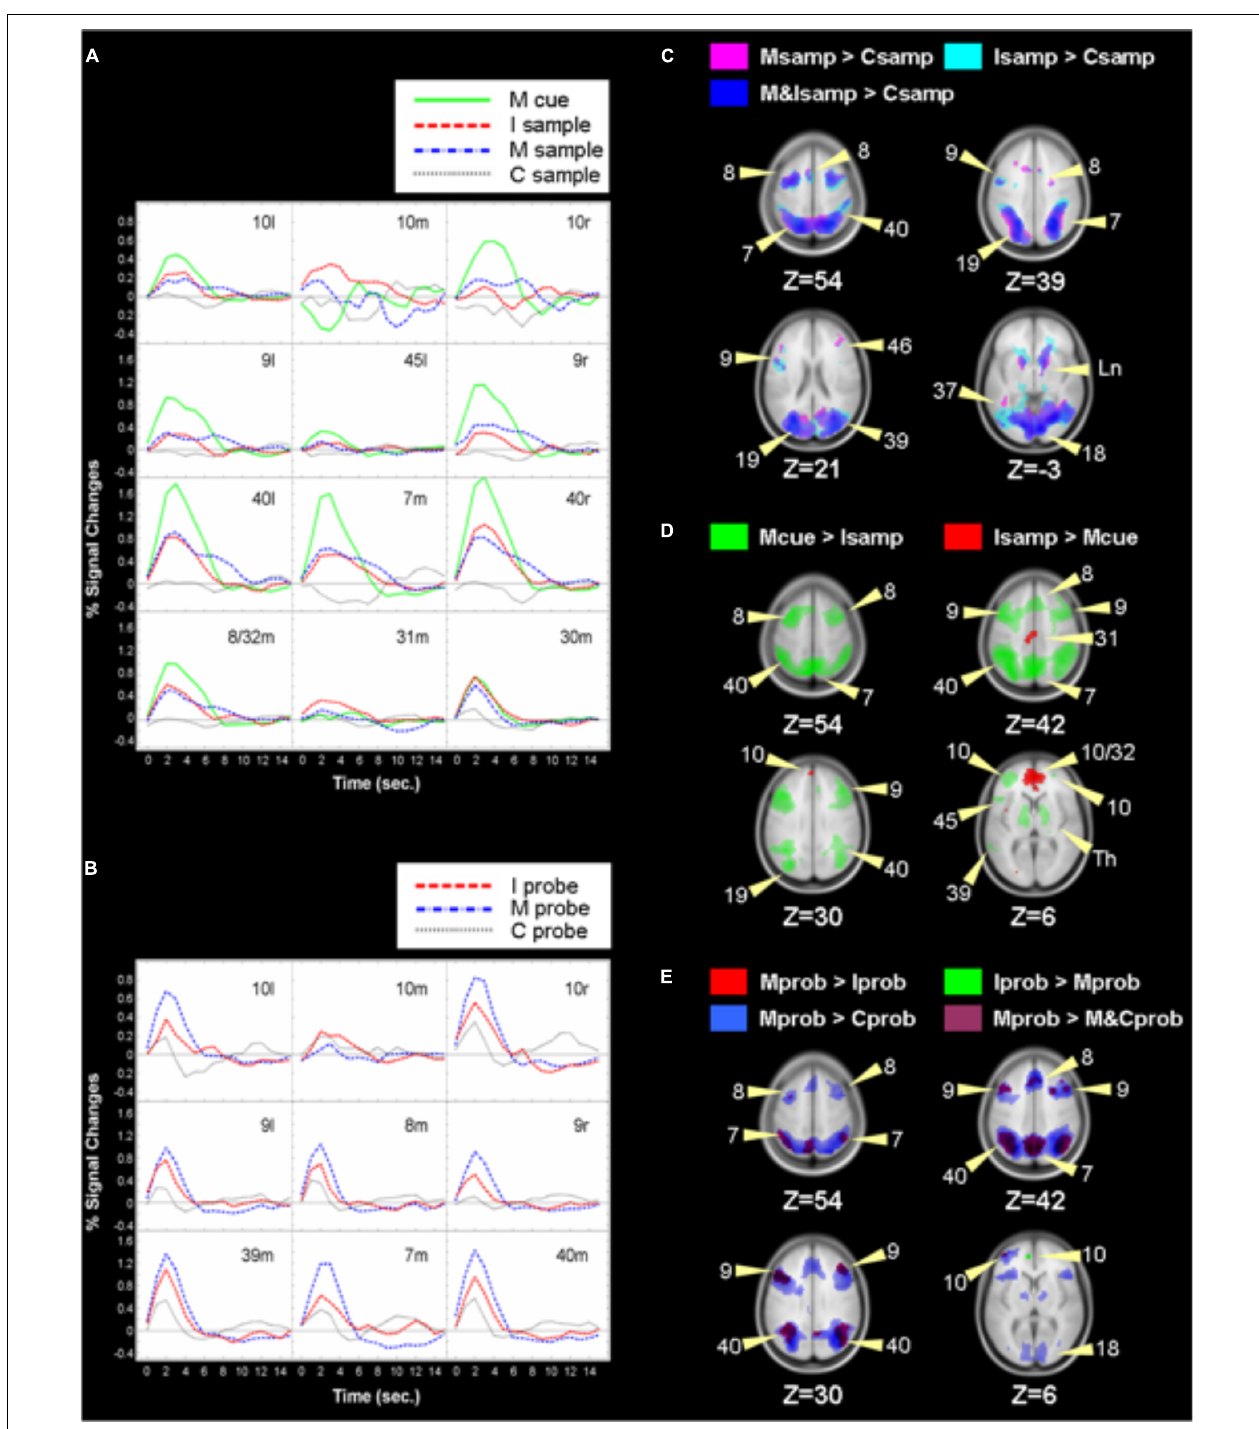
FIGURE 3 | Labels refer to Brodmann’s areas and left or right hemisphere or medial. For example, in panel (A) , 10l refers to left Brodmann Area 10 in the left hemisphere. The green line represents activation or BOLD intensity in that area during the manipulate trials’ cue phase. We compared responses for trial phases and depicted them in panels (C–E) , with labeled arrows indicating Brodmann Areas. The subtraction of the integrate trial sample phase from the manipulate trial change cue phase resulted in significant activations shown in green in panel (D) . The opposite subtraction produced the medial red activations. The green ROIs’ activations correspond to the green lines in panel (A) . Thus, activations in panels (A,B) can be seen to arise from the same-colored ROIs in panels (C–E) . Depicted in panel (A) : BOLD responses during sample and change cue phases of control, integrate, and manipulate trials for ROIs depicted in panels (C,D) . (B) BOLD responses for ROIs resulting from contrasting the probe phase in control, integrate, and manipulate trials, as depicted in panel (E) . C, Control, I, Integrate, M, Manipulate trial types. Samp, response to the sample phase of a trial type, cue, response to the change cue, prob, response to the probe phase.